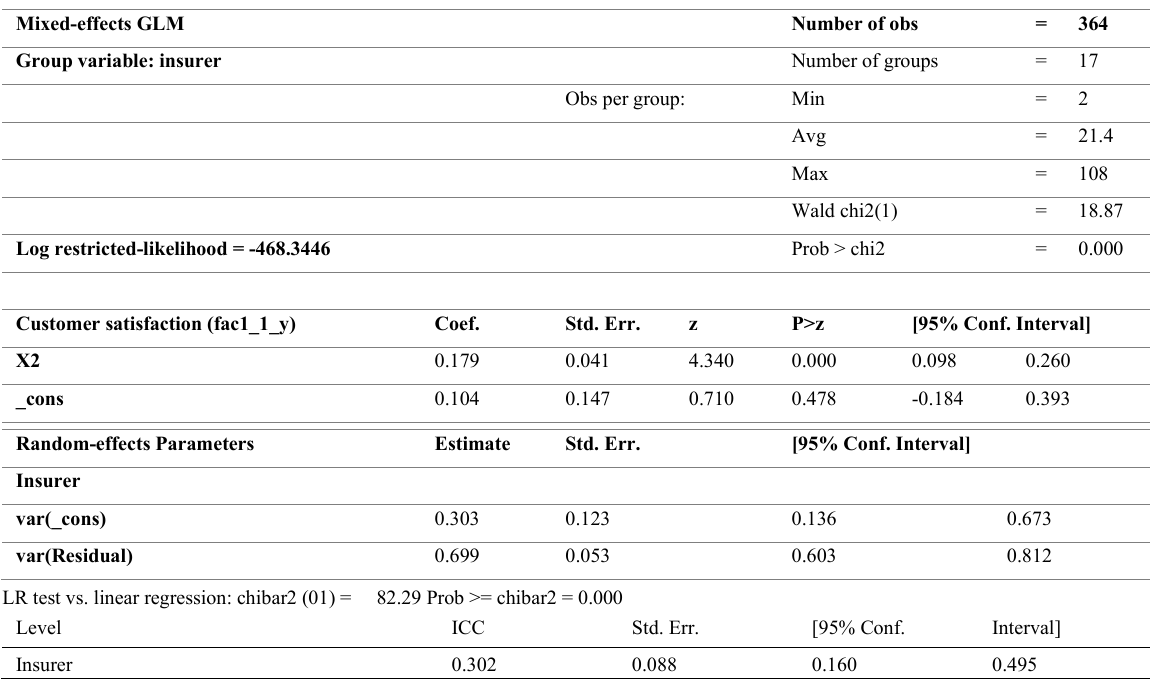
Table 6: Effect of Empathy: fixed effect with random intercept